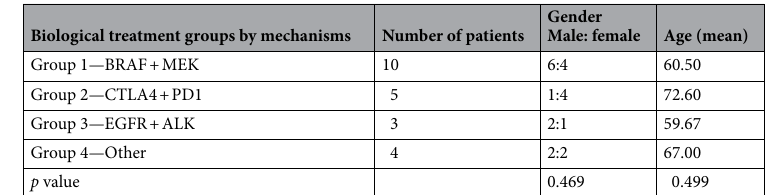
Table 2. Demographic charistricts of the groups.